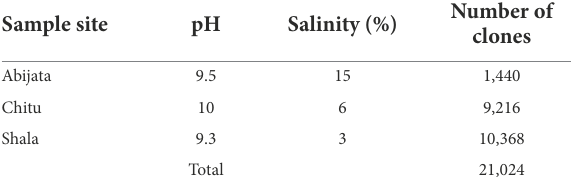
Supplementary Table 1). These GHs were categorized into 38 GH